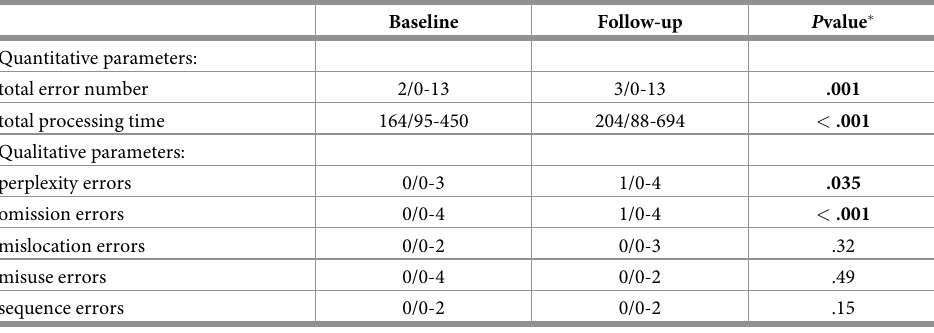
sequence errors 0/0-2 0/0-2 .15 Values are given as median/ range. (cid:3) Significant P values ( P < .005) are given in